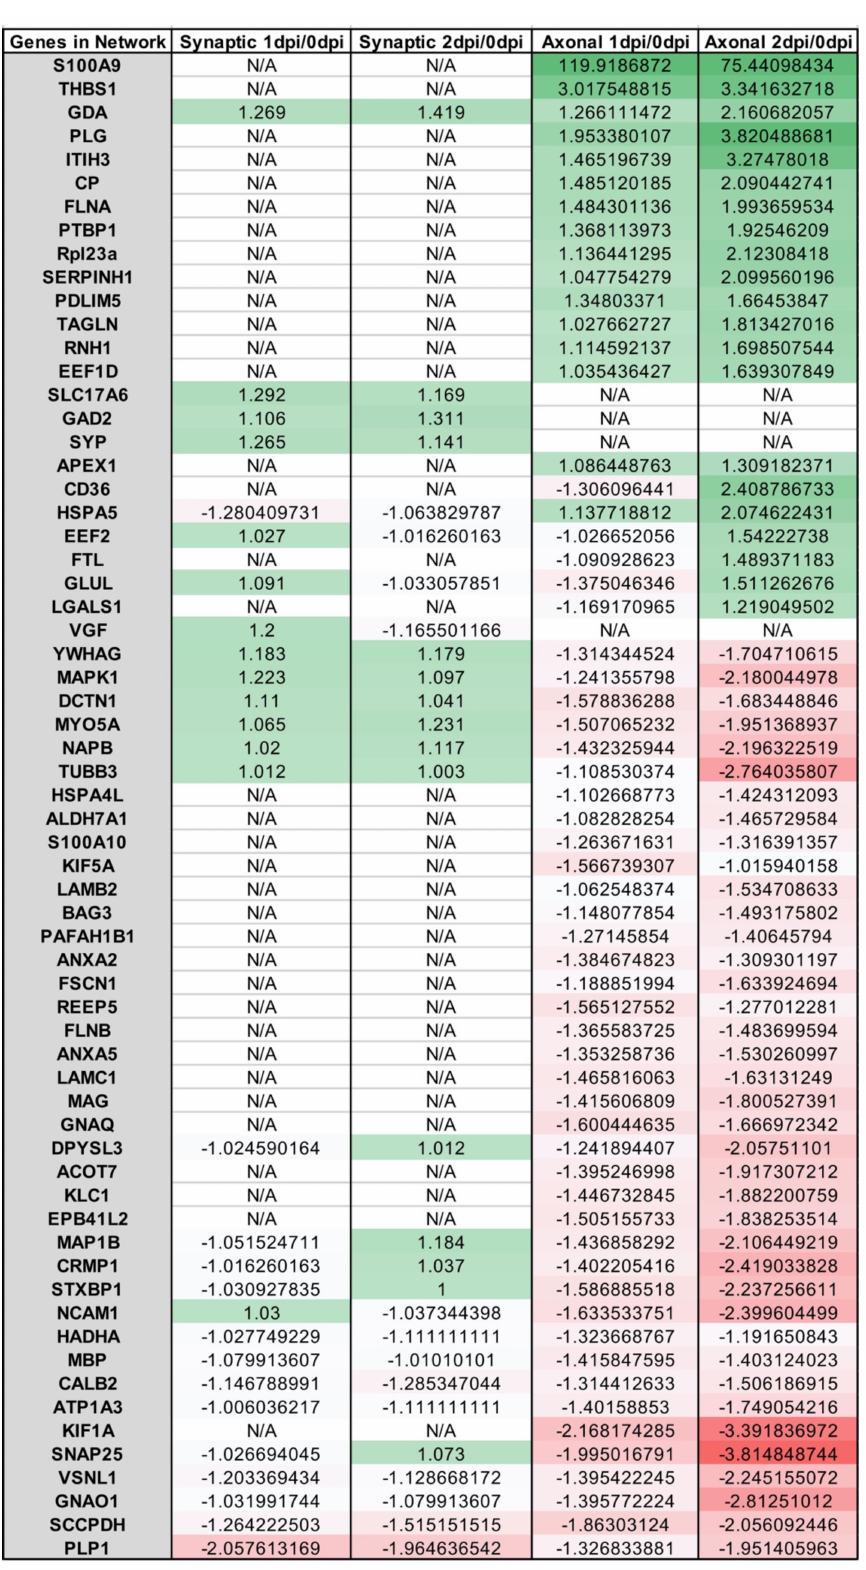
Figure A4. Summarised expression values of constituent proteins in BDNF-regulated mechanistic network depicted in Figure A3(B–E) in synapse and axon over 1–2